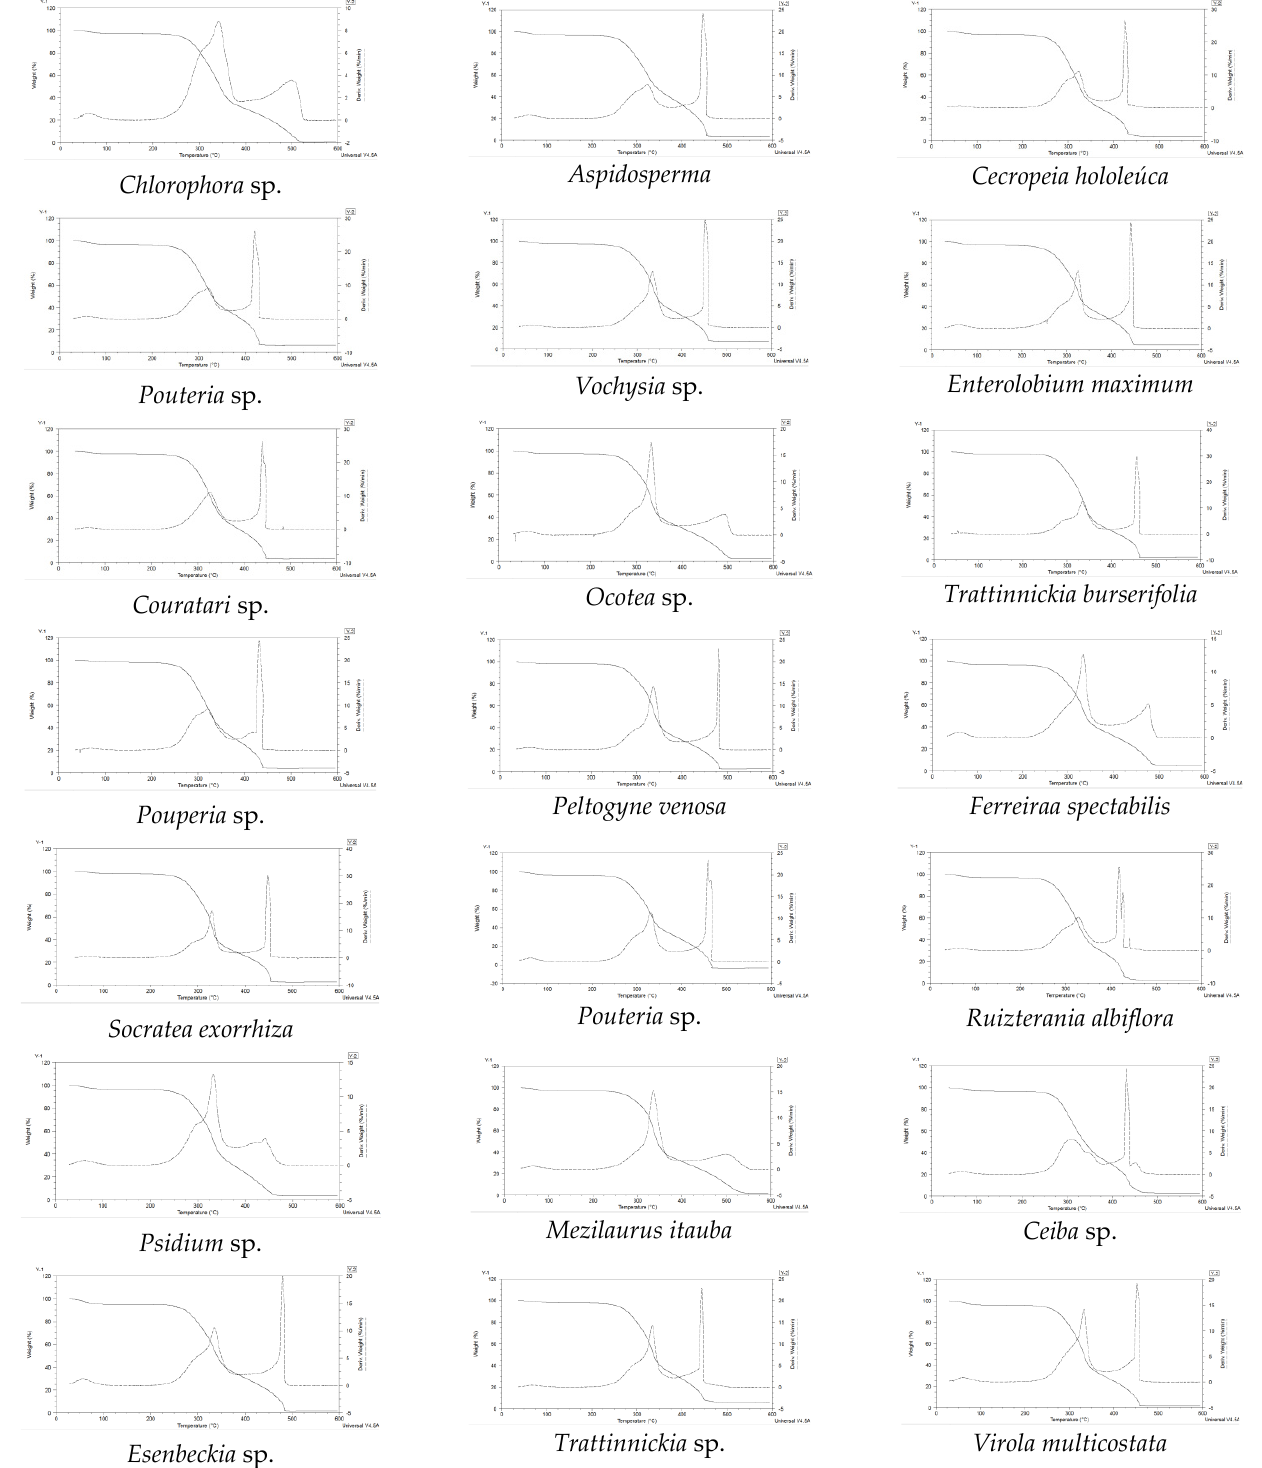
Figure 1. Thermogravimetric (TG) curves and derivative of thermogravimetric (DTG) curves of the samples of the woods with synthetic air at a flow rate of 80 mL min − 1 using a heating rate of 10 °C min − 1 .